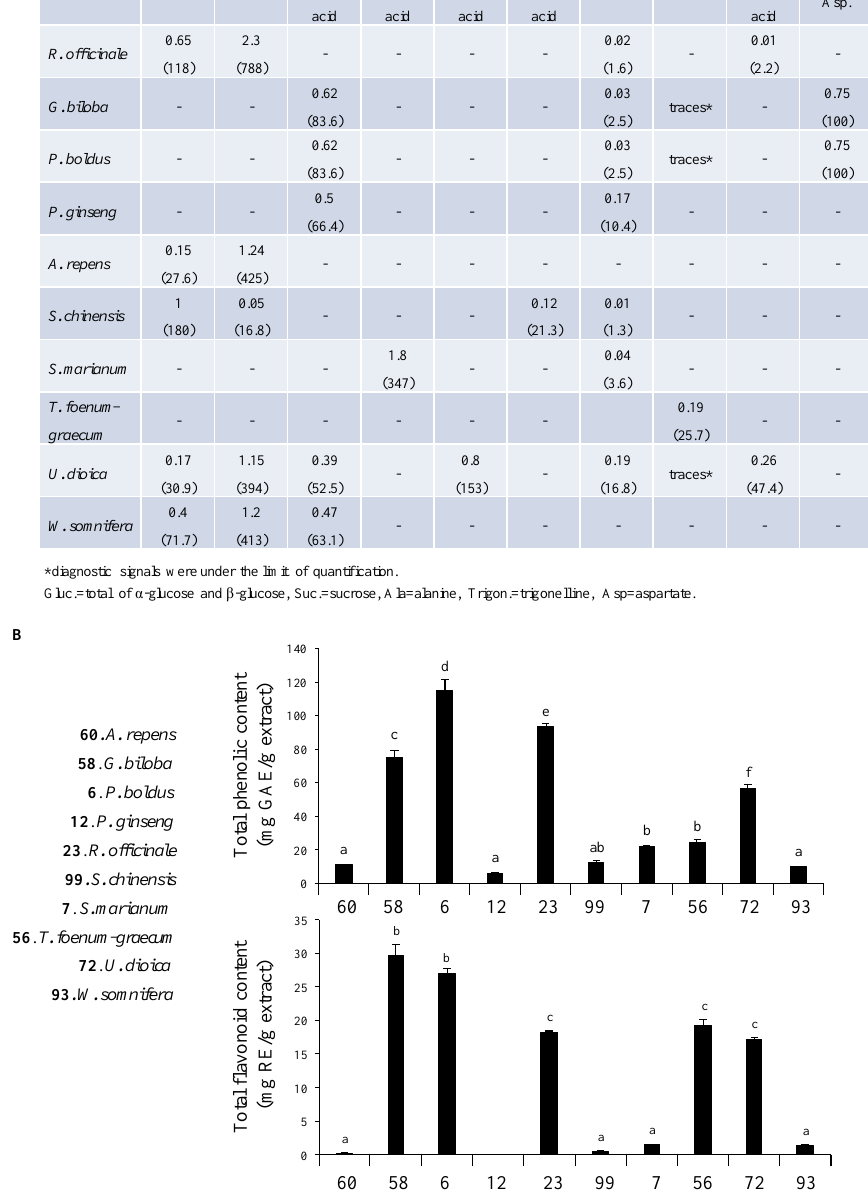
Figure 2. ( A ) Reported are the main metabolites identified in the extracts by 1 H NMR (nuclear magnetic resonance) profiling and quantified by comparison of metabolites diagnostic signal(s) and TMSP (trimethylsilylpropanoic acid) as internal standards. ( B ) Total phenolic (upper panel) and total flavonoid content (lower panel) of the most active extracts were measured. Different letters within the same assay indicate significant differences by one-way analysis of variance (ANOVA) test ( p < 0.05). Results are expressed as means ± SD (standard deviation) of three independent experiments.